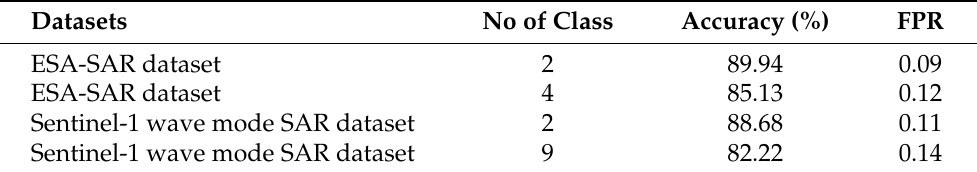
Table 2. Results for both dataset with different number of classes using second feature extraction approach (Dark spots, geometrical, physical, and characteristics